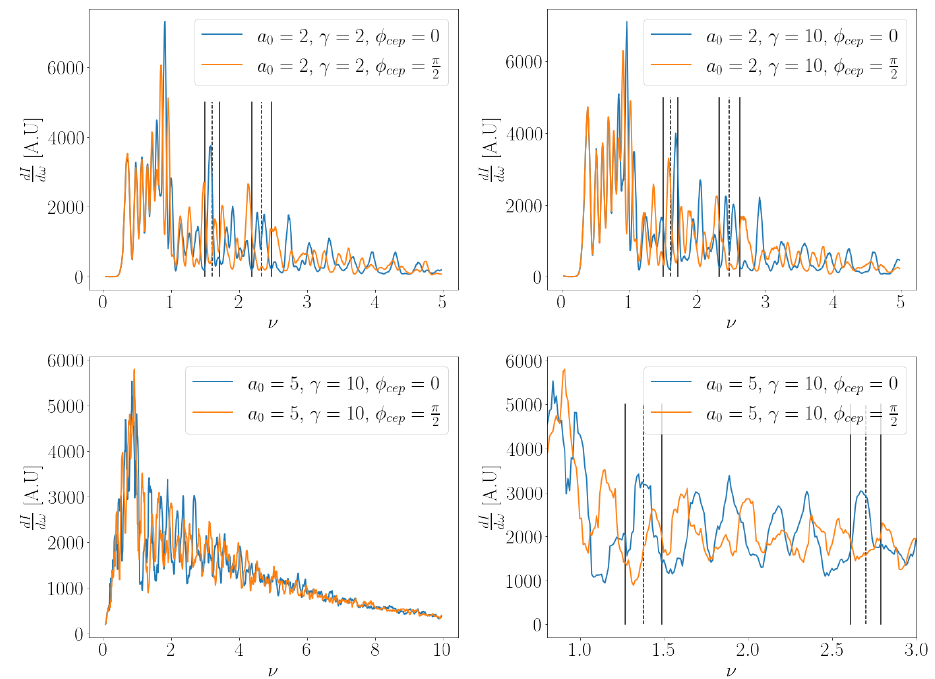
Figure 5. Simulation results for radiation collected within ϑ max = 1 plane wave (Equation (3) Ψ = 1). ( Top left ): a 0 = 2, γ = 2. The black dotted lines indicate the peak for φ cep = 0 (Equation (6)) and the solid black lines for φ cep = π and seventh harmonics. ( Top right ): same as the left but γ = 10. The shift in the harmonic peaks is due to the reduced ratio in the initial transverse and longitudinal momentum of the electrons. ( Bottom left ): a 0 = 5, γ = 10. Due to the stronger intensity of the laser pulse more energy is emitted in the higher harmonics. ( Bottom right ): zoomed in on a smaller frequency range to show φ cep better. The black dotted lines indicate the peak for φ cep = 0 (Equation (6)) and the solid black lines for φ cep = π (Equation (8)) for the 19th and 23rd 2